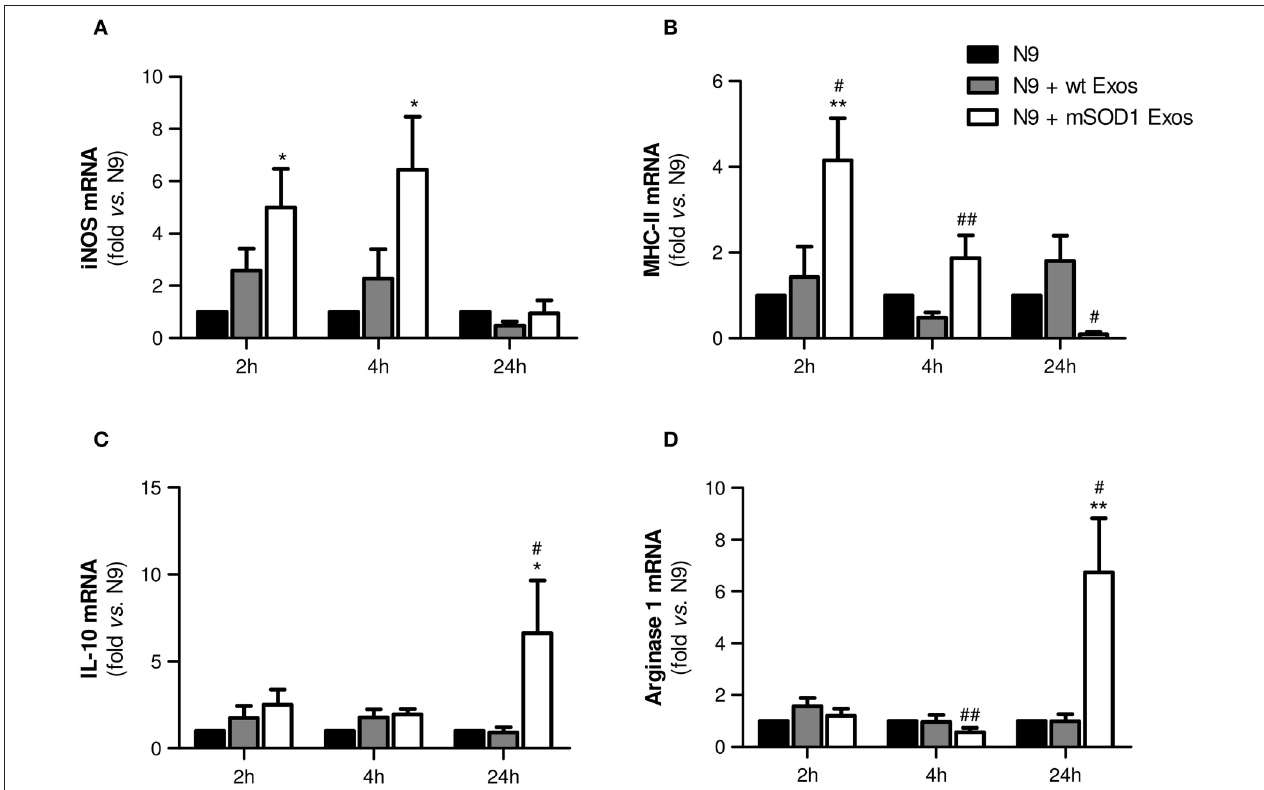
FIGURE 6 | Exosomes from NSC-34 motor neurons (MNs) mutated in G93A (mSOD1) trigger early upregulation of M1- and late expression of M2-markers in N9 microglia. N9 microglia cells were incubated for 2, 4, and 24 h with exosomes (Exos) from wild-type (wt) NSC-34 MNs and mSOD1 NSC-34 MNs (N9 + wt Exos and N9 + mSOD1 Exos, respectively), as indicated in methods. Non-treated cells were considered as control. Relative mRNA levels of (A) inducible form of nitric oxide synthase (iNOS), (B) major histocompatibility complex-class-II (MHC-II), (C) interleukin-10 (IL-10), and (D) arginase-1 were determined by qRT-PCR in total RNA. Results are mean ( ± SEM) from at least eight independent experiments and are expressed as fold change relatively to non-treated N9 microglia. Differences between the three different groups at each time point were obtained by one-way ANOVA followed by Bonferroni post-hoc correction. * p < 0.05 and ** p < 0.01 vs. non-treated cells; # p < 0.05 and ## p < 0.01 vs. treatment with exosomes from wt NSC-34 MNs.